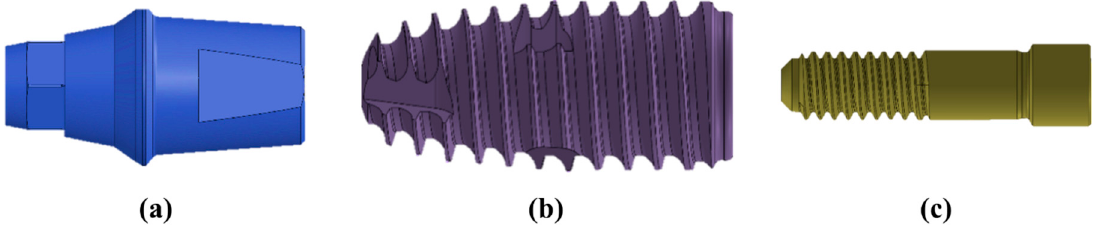
Figure 1. Three-dimensional CAD model of dental implant system used in this study: ( a ) abutment, ( b ) implant fixture, and ( c ) abutment screw.